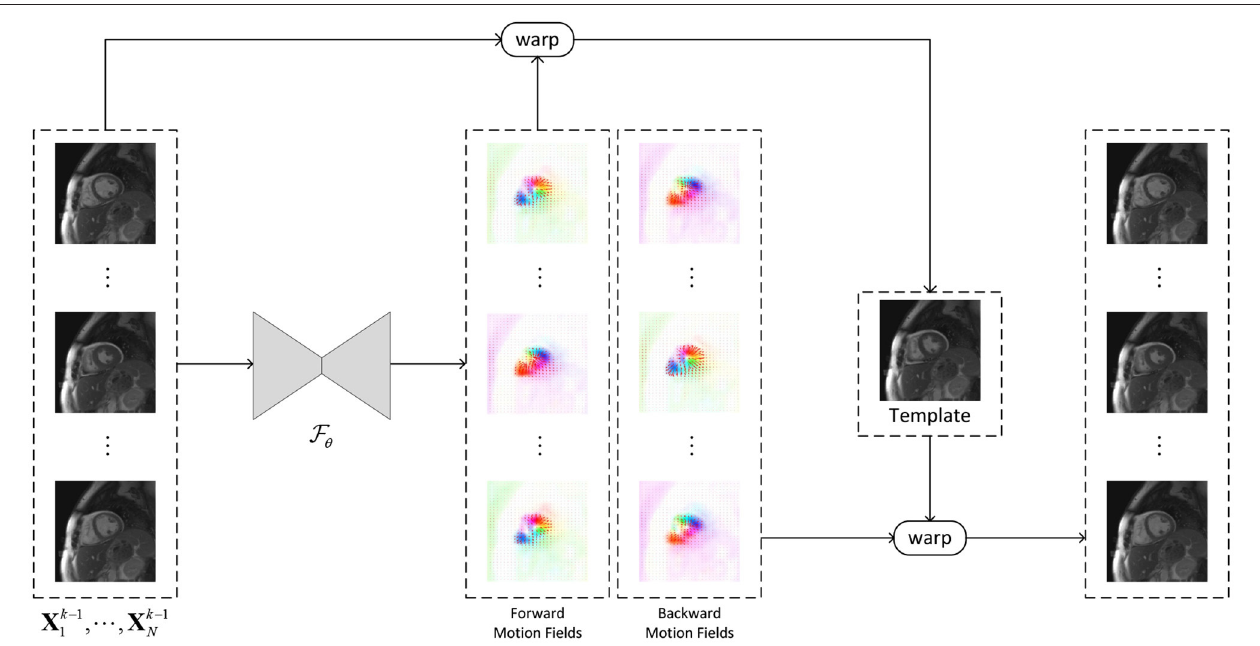
FIGURE 1 | The framework of the learning-based groupwise registration network (GRN, F θ ). The GRN takes a sequence of images as input and generates the invertible forward and backward motion fields between an implicit template and the dynamic images, where the template is the average of the warped dynamic images with the forward motion. A new sequence of dynamic images can be generated by warping the template using the backward motion fields.